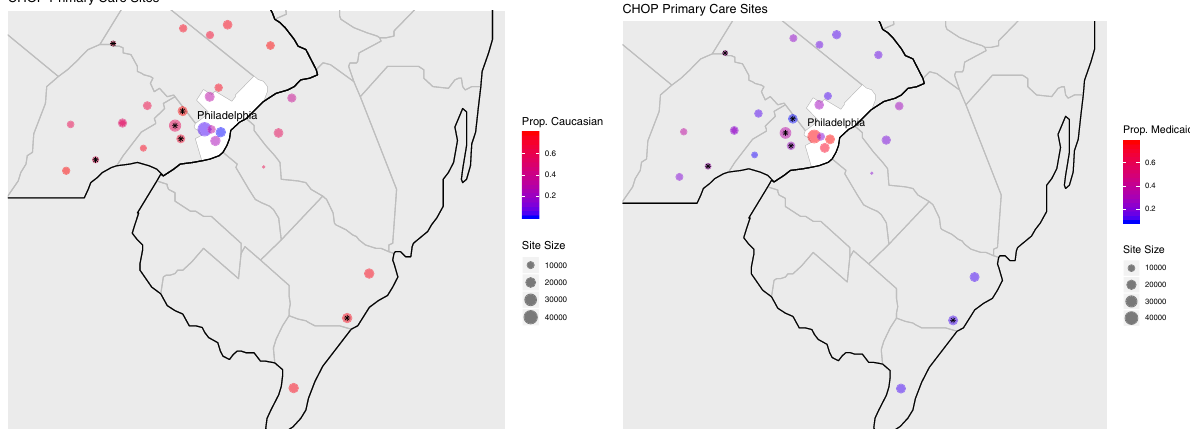
Figure 8. Geographical map of 27 CHOP primary care sites across greater Philadelphia region. In the left map, the proportion of patients of Caucasian race are depicted for each site. In the right map, the proportion of patients using public insurance (Medicaid) at each site is depicted. The size of each site on each map is proportional to the number of patients at the given site. Stars indicate sites used in our data